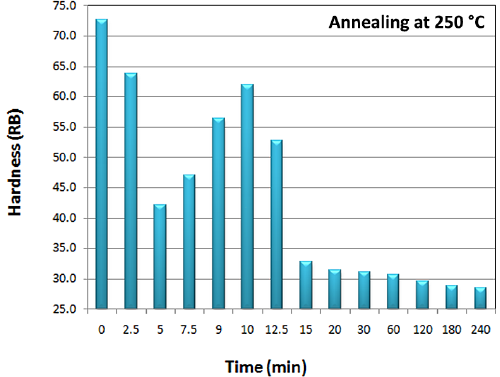
Figure 4. Hardness testing vs. annealing at 250 ◦ C for the 50% cold rolled sample at different times.